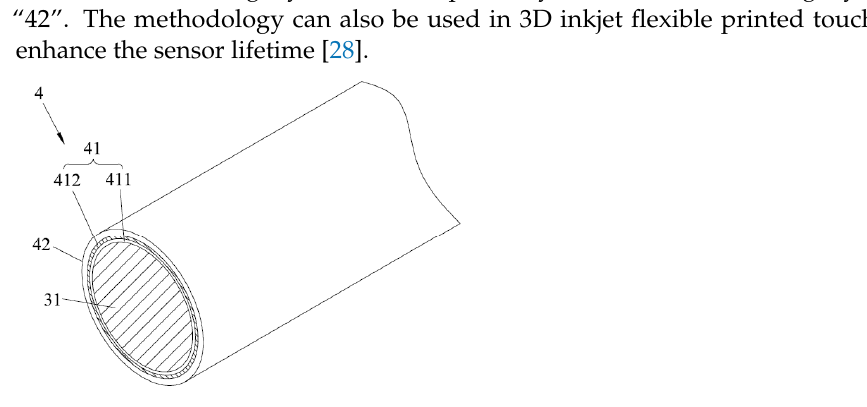
Figure 8. Schematic diagram of the bonding wire ALD-coated with Al 2 O 3 thin film.